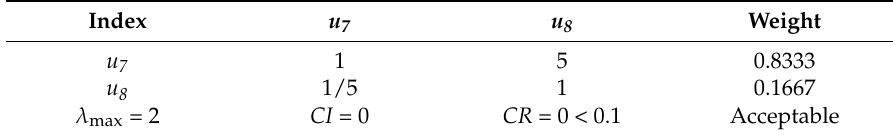
Table 6. Matrix construction and weight calculation of indices associated with the vulnerability.